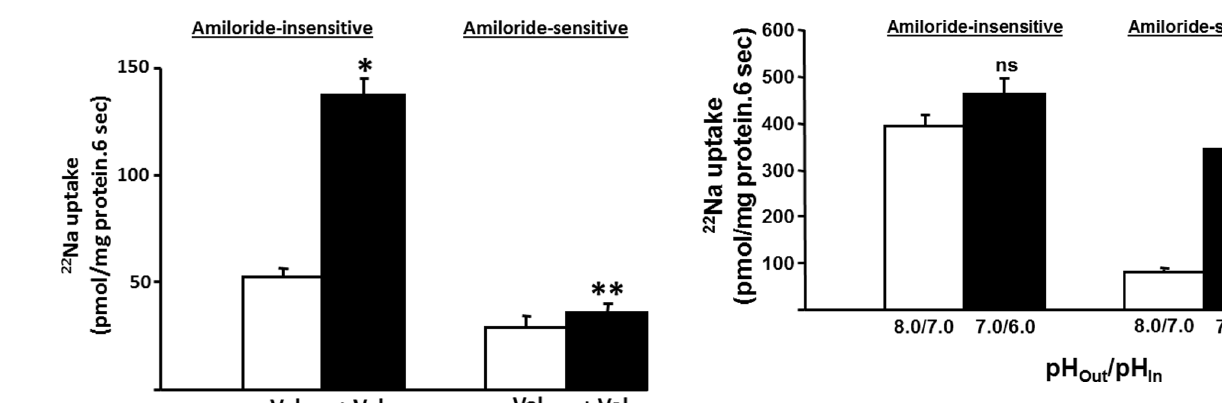
Figure 10. Effect of one-unit pH-gradient with varying proton concentrations on Na-HCO 3 cotransport activities in basolat- eral membrane vesicles from proximal colon. Proton/HCO 3 gradient-driven 22 Na uptake (0.1 mM) was measured as described in the Method section with one unit acid outward pH gradient at different extravesicular and intravesicular pH in presence and absence of inhibitors (1 mM amiloride or 1 m M HOE694). One-unit outward acid pH-gradients with both low (pHo/pHi: 8.0/7.0) and high (pHo/pHi: 7.0/ 6.0) proton concentrations stimulated amiloride-insensitive Na-HCO 3 cotransport, while amiloride-sensitive Na-HCO 3 cotransport was sub- stantially stimulated only at high proton concentrations. Uptake obtained in presence of amiloride represented amiloride-insensitive proton/HCO 3 gradient-driven uptake. Amiloride-sensitive uptake (which also includes HOE694 sensitive Na-H exchange) was calculated by subtracting uptake obtained in presence of amiloride from that of uptake in the absence of inhibitors. HOE694-sensitive uptake was calculated by subtracting uptake obtained in presence of HOE694 from that of uptake in the absence of inhibitors. Amiloride-sensitive proton/ HCO 3 gradient-driven uptake was calculated by subtracting HOE694- sensitive uptake from that of amiloride-sensitive uptake. * p , 0.001 - compared to 8.0/7.0 (pHo/pHi) in amiloride-sensitive; ns: not significant - compared to 8.0/7.0 (pHo/pHi) in